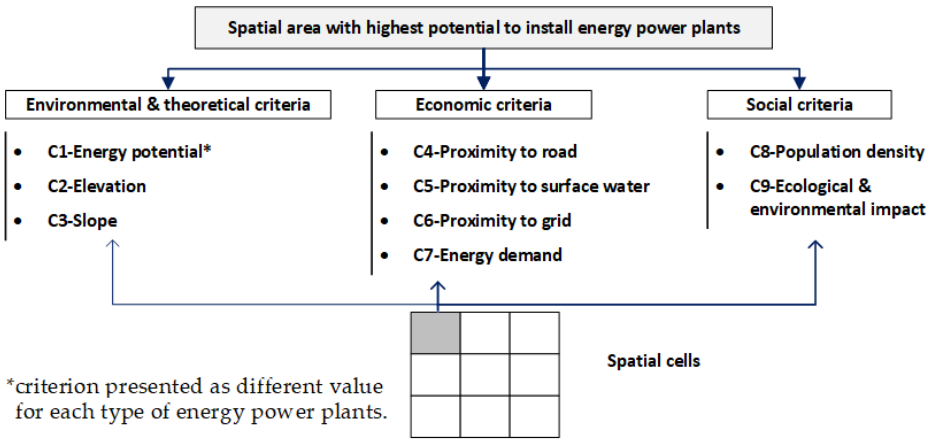
Figure 3. The analytic hierarchy of spatial siting potential evaluation.